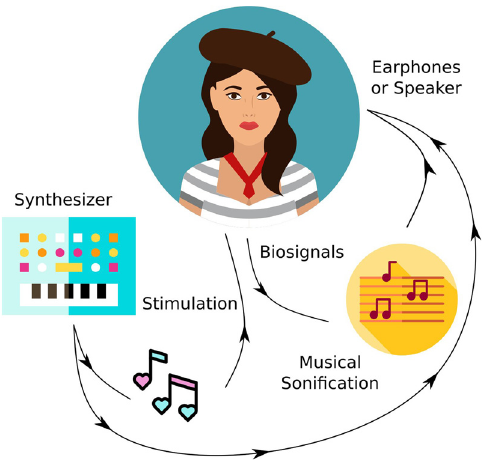
Figure 3: PLAY ME for a single